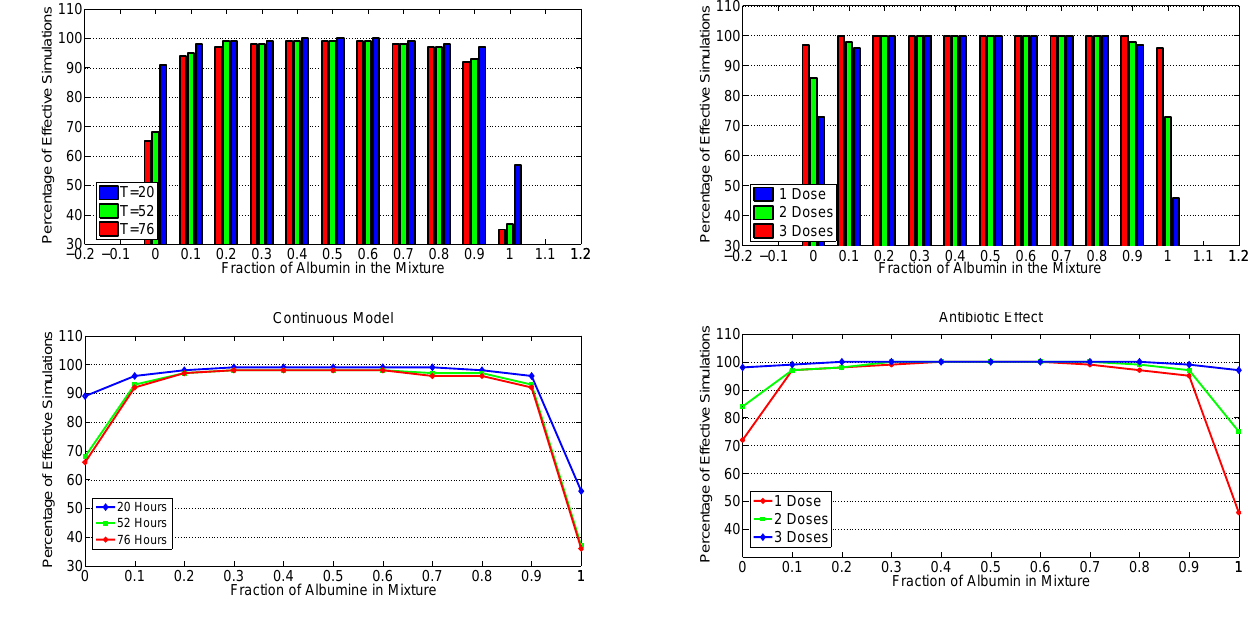
Fig. 2. Comparison of the discrete cellular automata 2-D model (above) and the continuous 1-D differential equation model (below) for T = 20 , T = 52 and T = 76 .